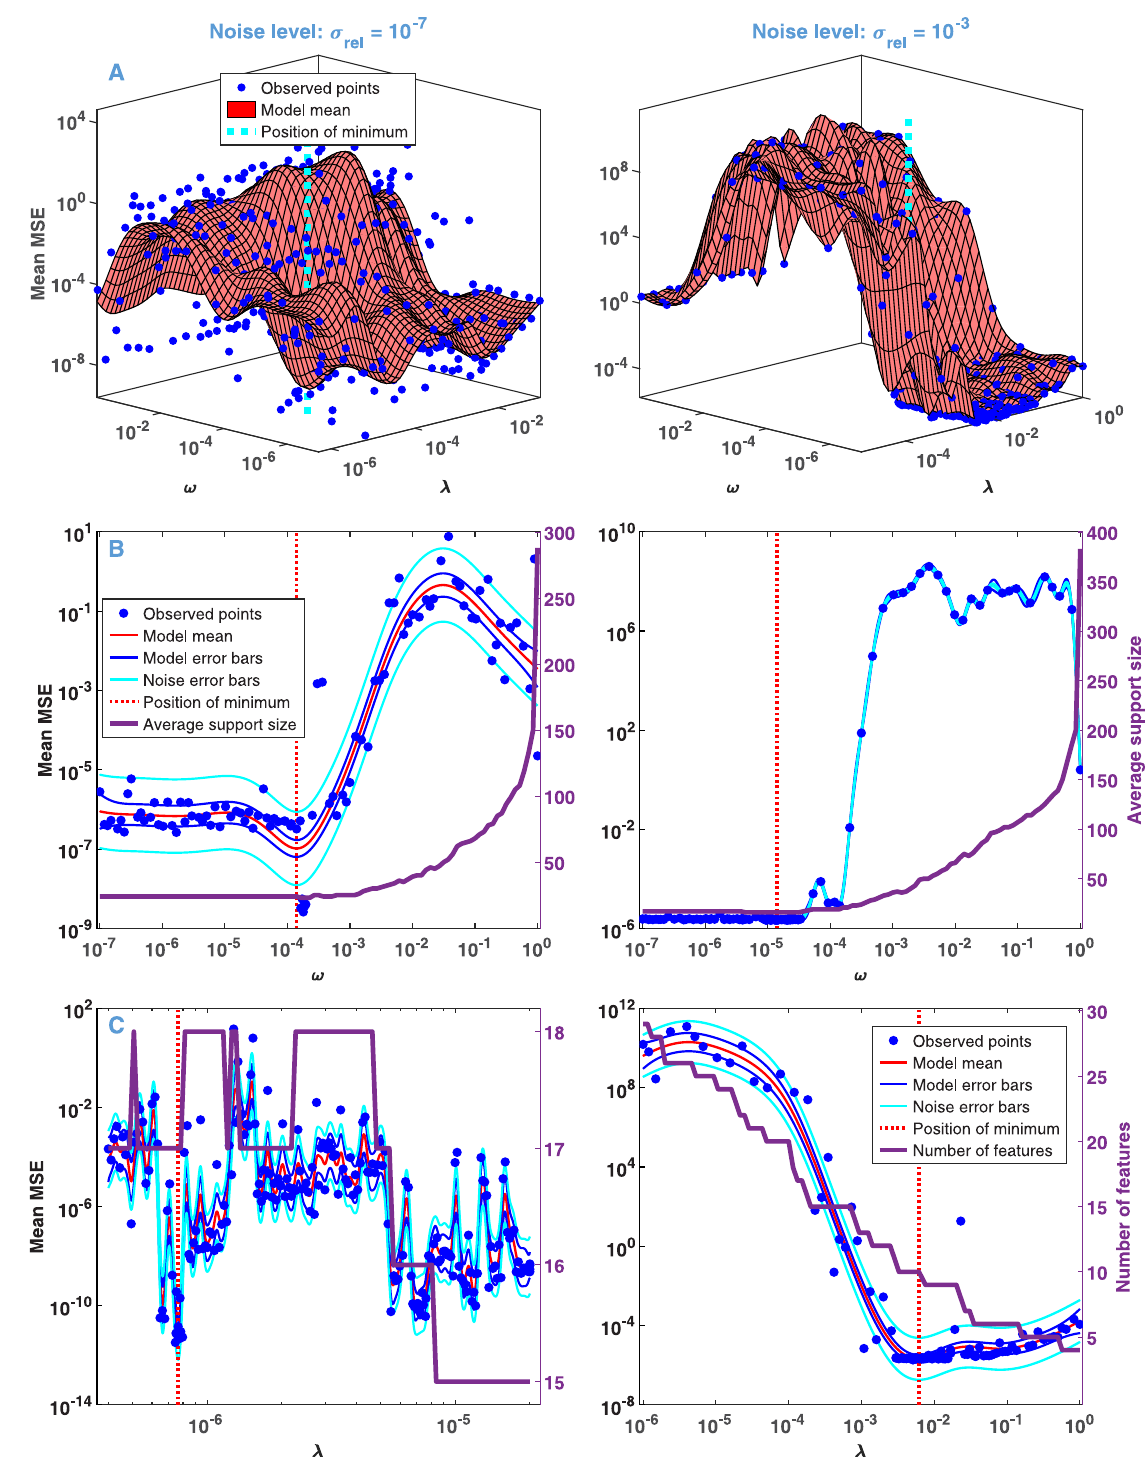
Fig 3. Model selection by BO based on RCV(nv) from the simulated data with different noise levels. Results of the steps of Algorithm 1. (A) Step 1: BO in the joint space of λ and ω , explored by the BO process at the blue dots. (B) Step 2: BO in the space of ω with the fixed value of λ obtained in Step 1. The purple line (right axis) represents the average support size against ω . (C) Step 3: BO in the space of λ with the fixed value of ω obtained in Step 2. The purple line (right axis) represents the number of features against λ .